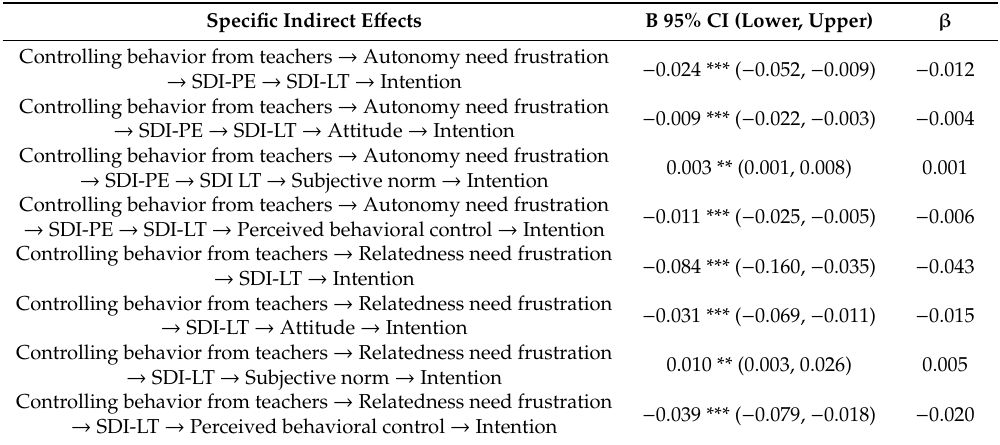
Table 4. Specific indirect e ff ects from perceived controlling behavior from teachers on students’ intention to be physically active in their leisure